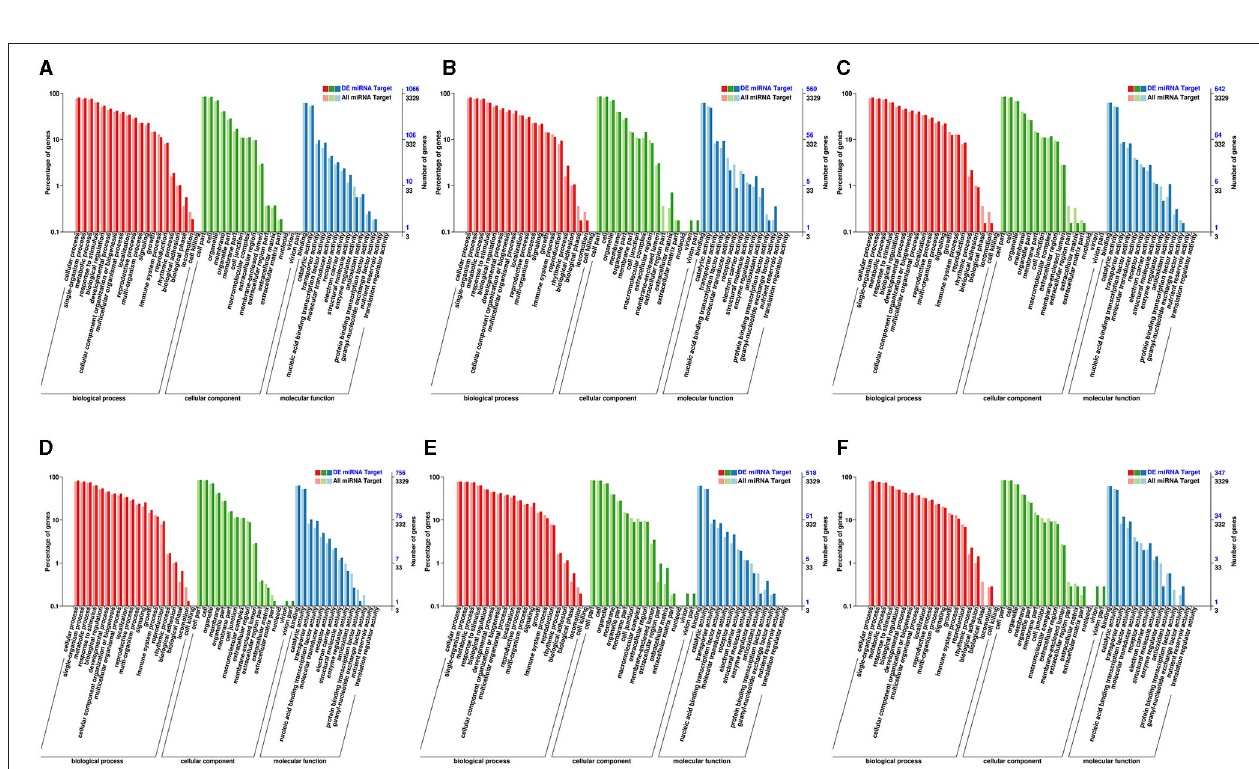
FIGURE 5 | GO enrichment analysis mapped to potato Genome during cold stress in the potato. (A) The GO enrichment analysis between S01 vs. S02; (B) the GO enrichment analysis between S01 vs. S04; (C) the GO enrichment analysis between S01 vs. S05; (D) the GO enrichment analysis between S02 vs. S04; (E) the GO enrichment analysis between S02 vs. S05; (F) the GO enrichment analysis between S04 vs. S05.